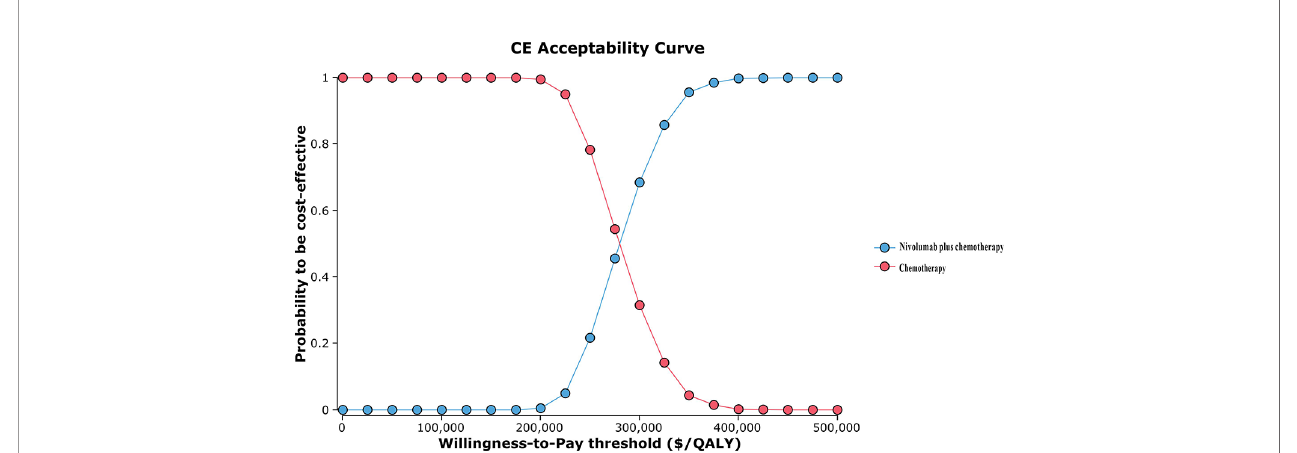
FIGURE 4 | Cost-effectiveness acceptability curve. QALY, quality-adjusted life-year; CE, cost-effectiveness.